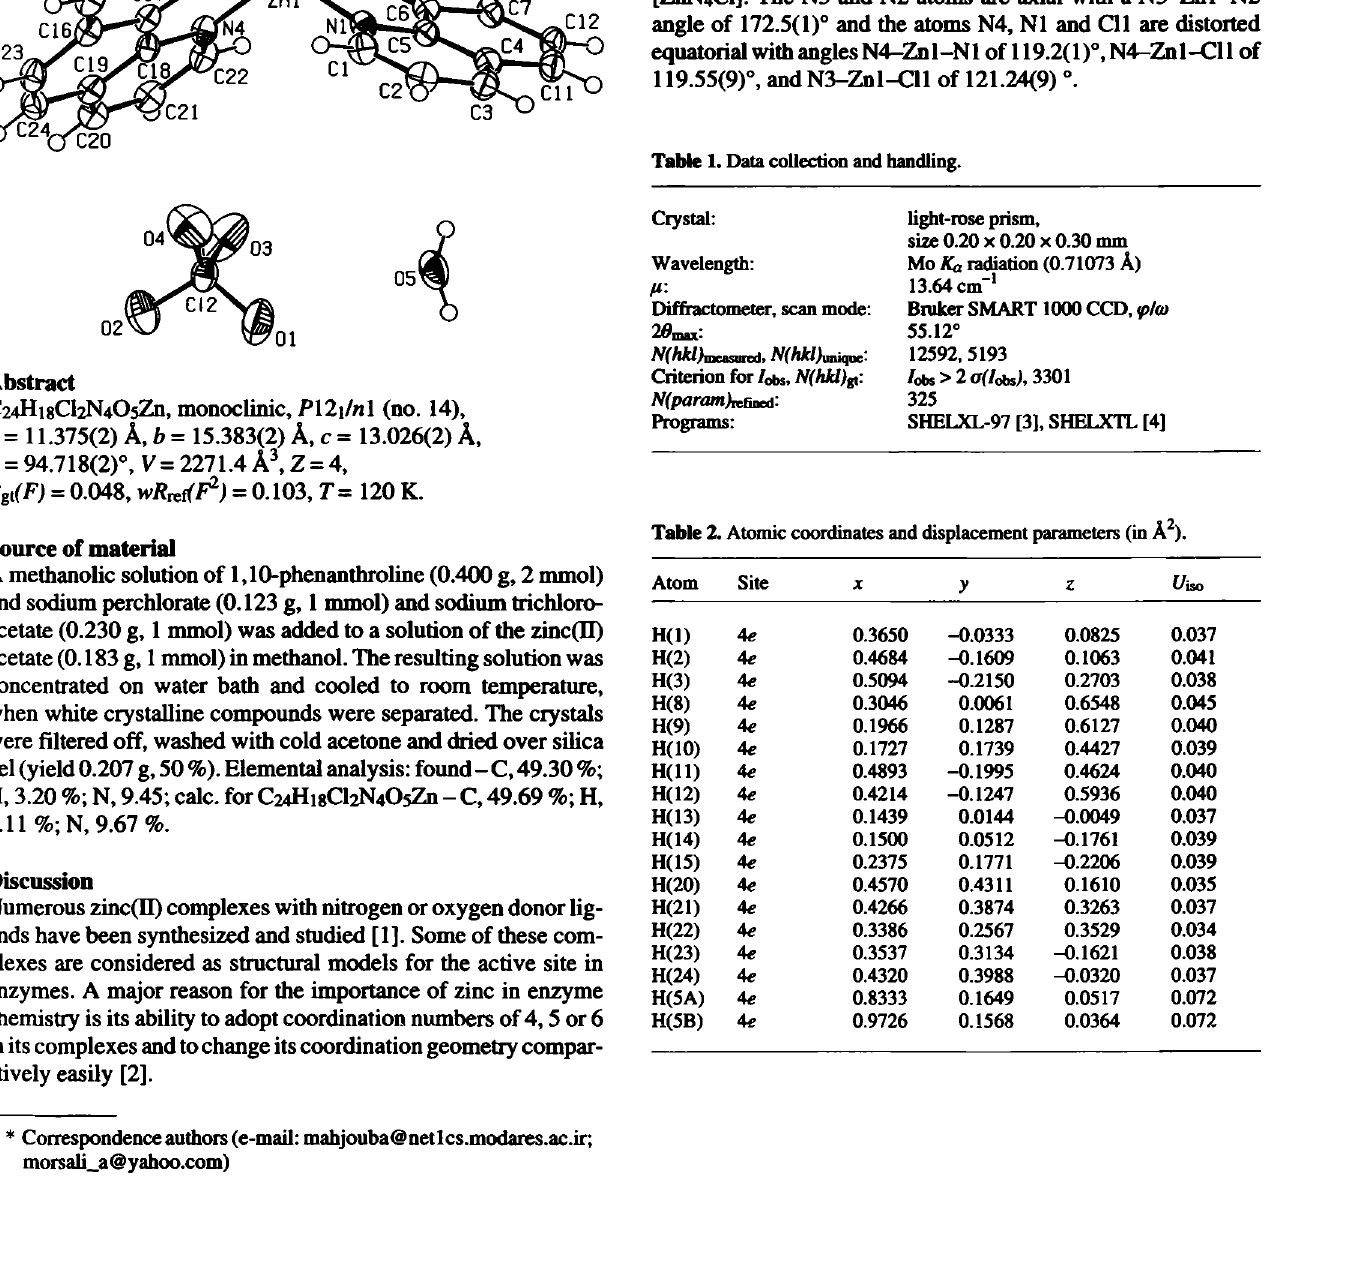
Table 1. Data collection and handling.